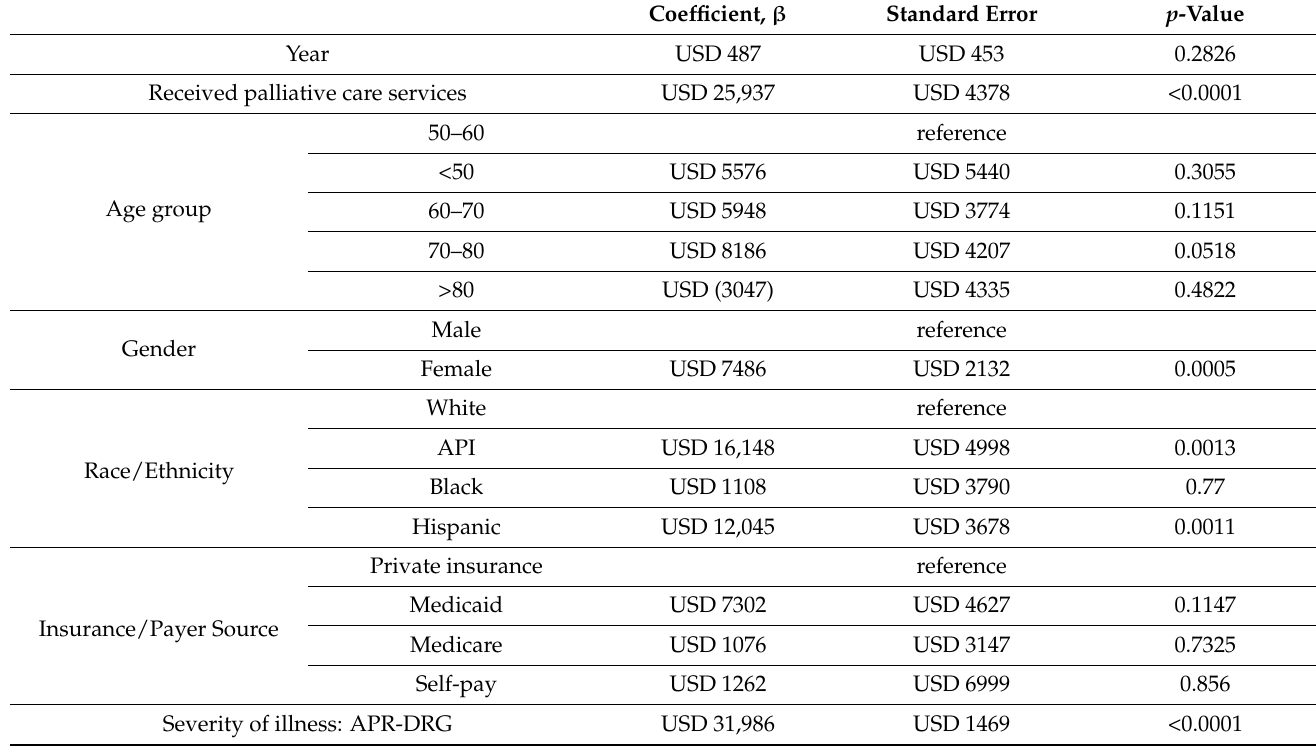
Table 4. Factors associated with hospital charges in ECC in US hospitals from 2007 to 2016. NIS Data.